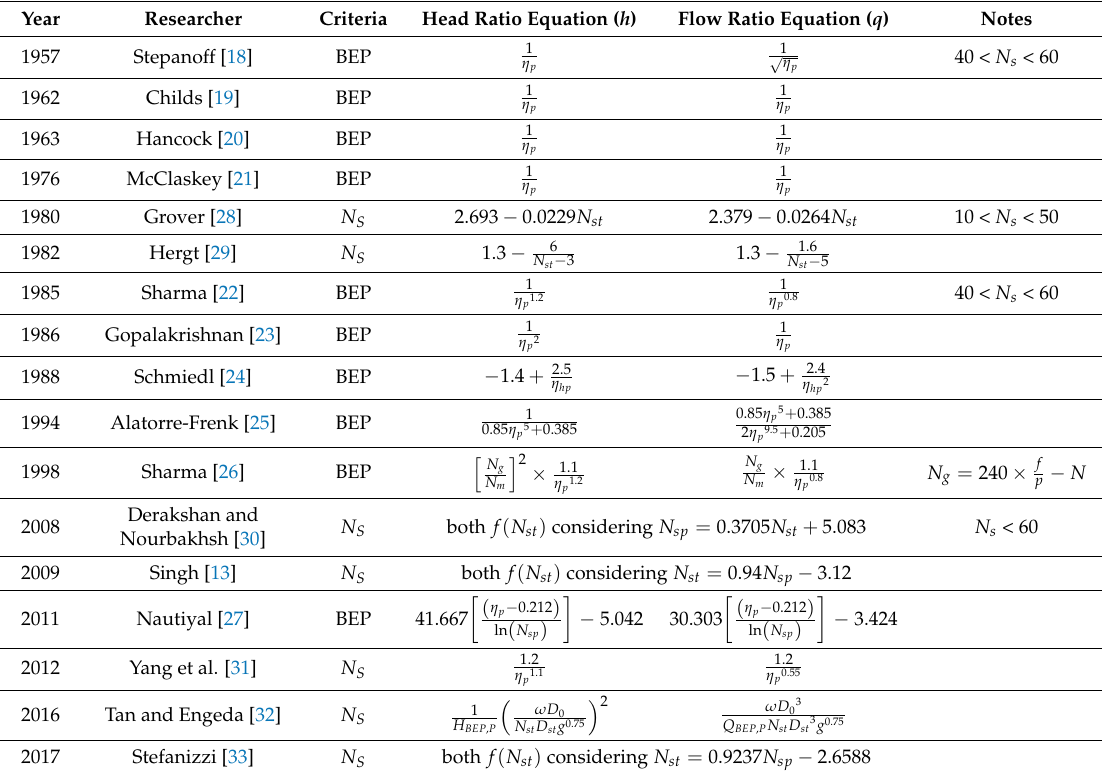
Table 1. PAT performance models in chronological